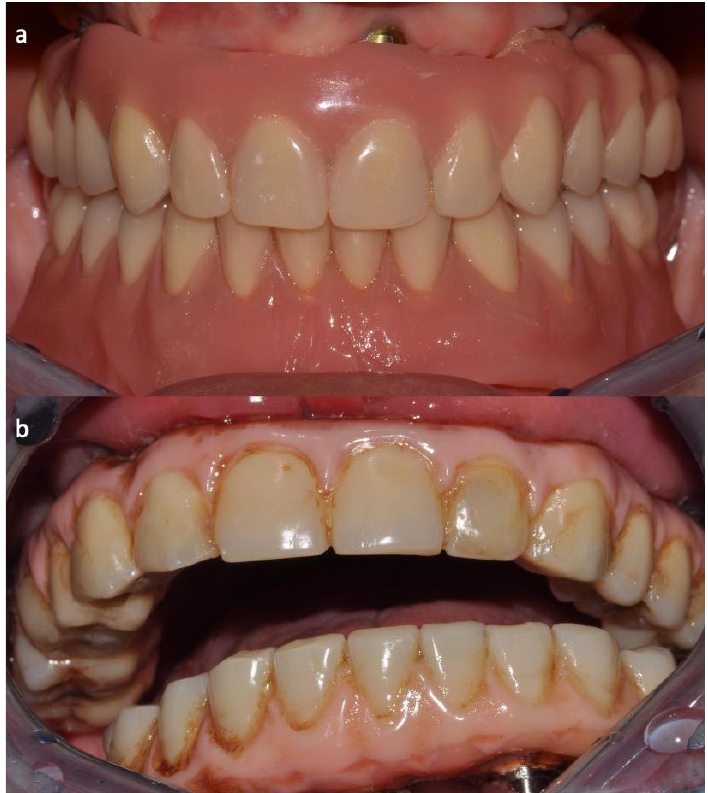
Figure 3. Clinical appearance after 3 months. The onset of chlorhexidine-related stains is evident. ( a ) Experimental group; ( b ) control group. ( a ) Experimental group; ( b ) control